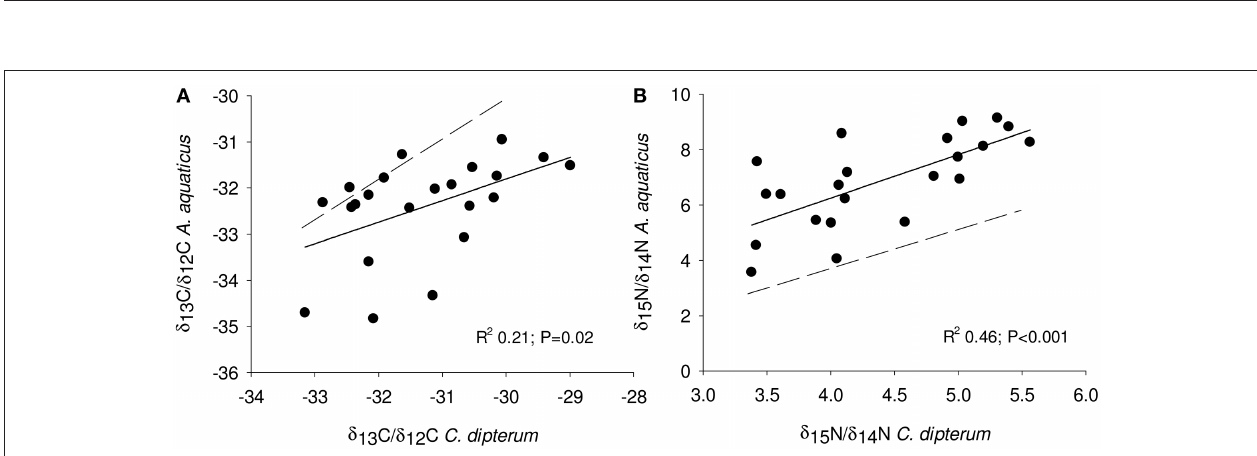
FIGURE 3 | Linear least square regression of nitrogen (A) and carbon (B) isotopes between A. aquaticus and C. dipterum . Line fit, R 2 and significance level are depicted in both panels. Dotted line indicates hypothetical 1:1 relationship between A. aquaticus and C. dipterum .